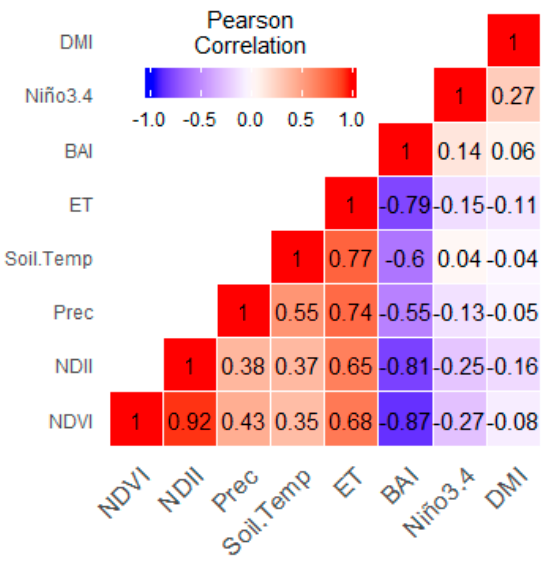
Figure 7. The heat map of Pearson correlation coefficients for NDVI, NDII, precipitation (Prec), soil temperature (Soil.Temo), ET, BAI, Niño3.4, and DMI.